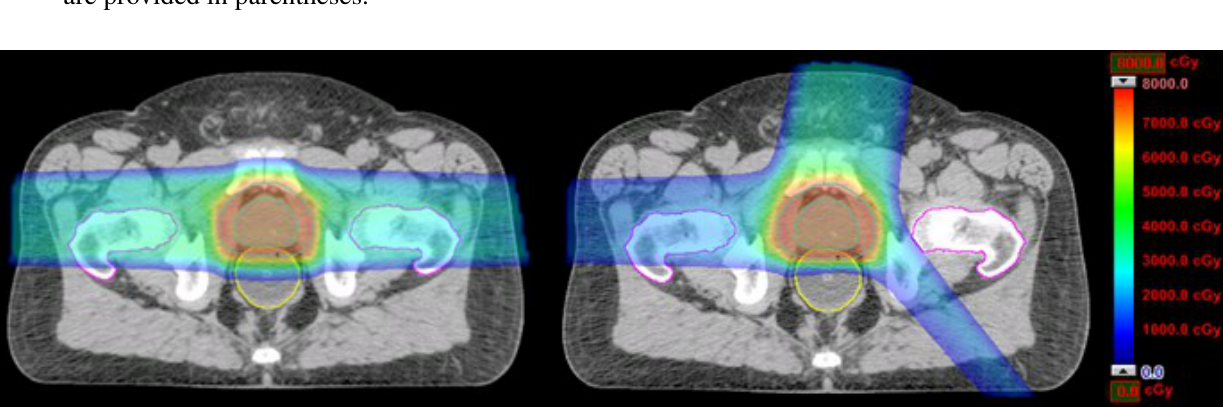
Figure 1. Dose distribution plots for the conventional two-angle IMPT plans (90°, 270°) and the class three-angle IMPT plans (10°, 140°, 270°) for one prostate cancer patient.